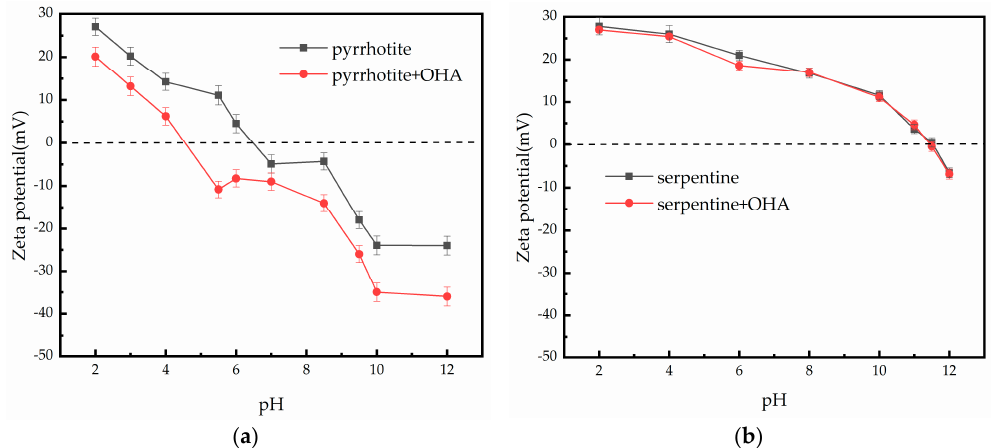
Figure 6. Effect of OHA on the zeta potentials of pyrrhotite ( a ) and serpentine ( b ).